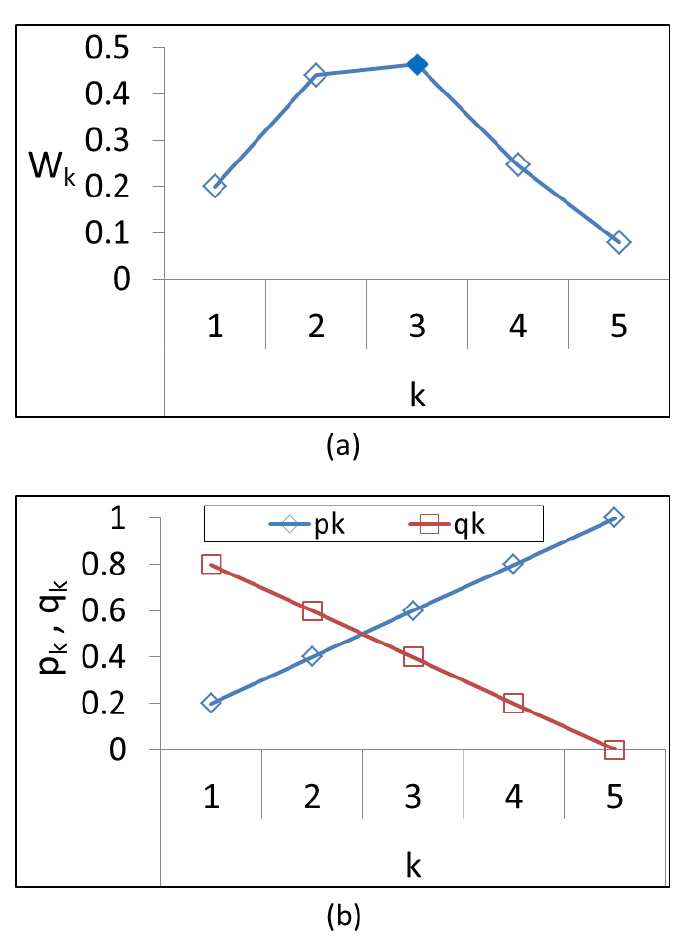
Figure 3. Success and failure concept. ( a ): Plot of W k . ( b ): Plot of p k and q k